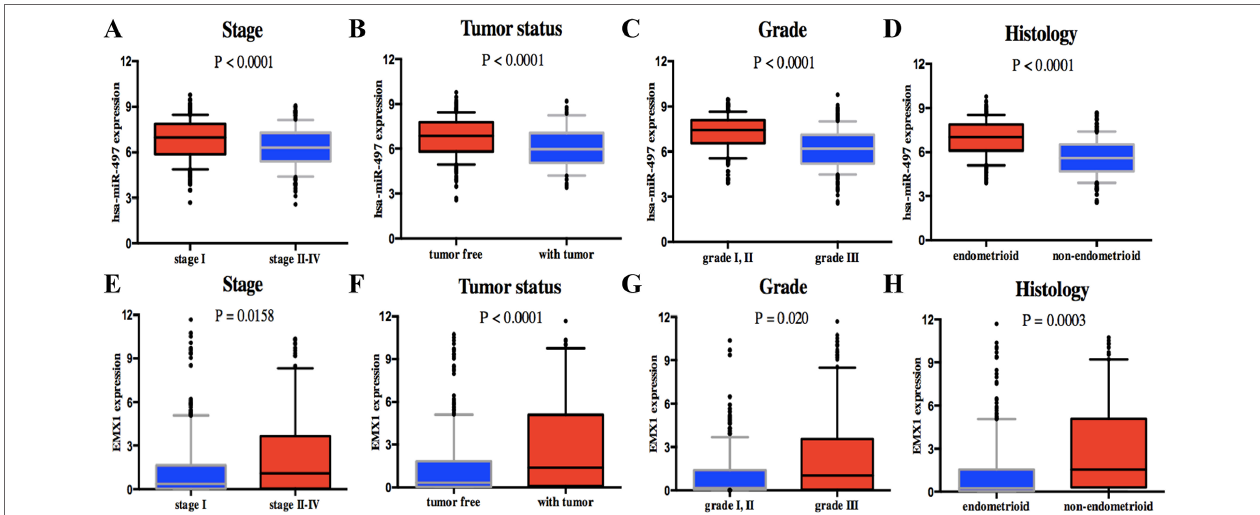
FIGURE 7 | Association with DEG expression and clinicopathologic characteristics, including has-miR-497 expression associated with (A) stage, (B) tumor status, (C) grade, and (D) histology and EMX1 expression associated with (E) stage, (F) tumor status, (G) grade, and (H) histology. P values were calculated using t test.